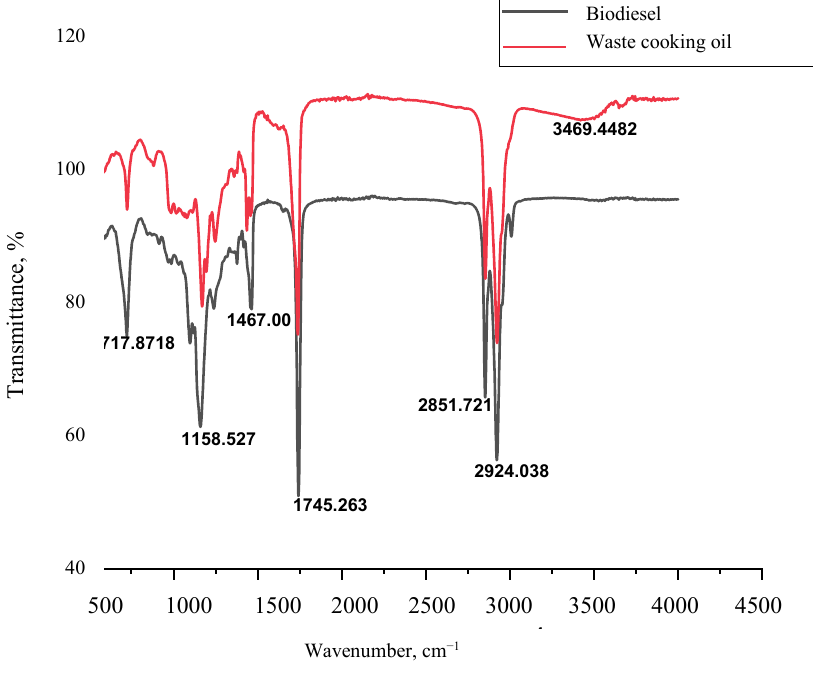
Fig. 4. FTIR plots for waste cooking oil and the synthesized